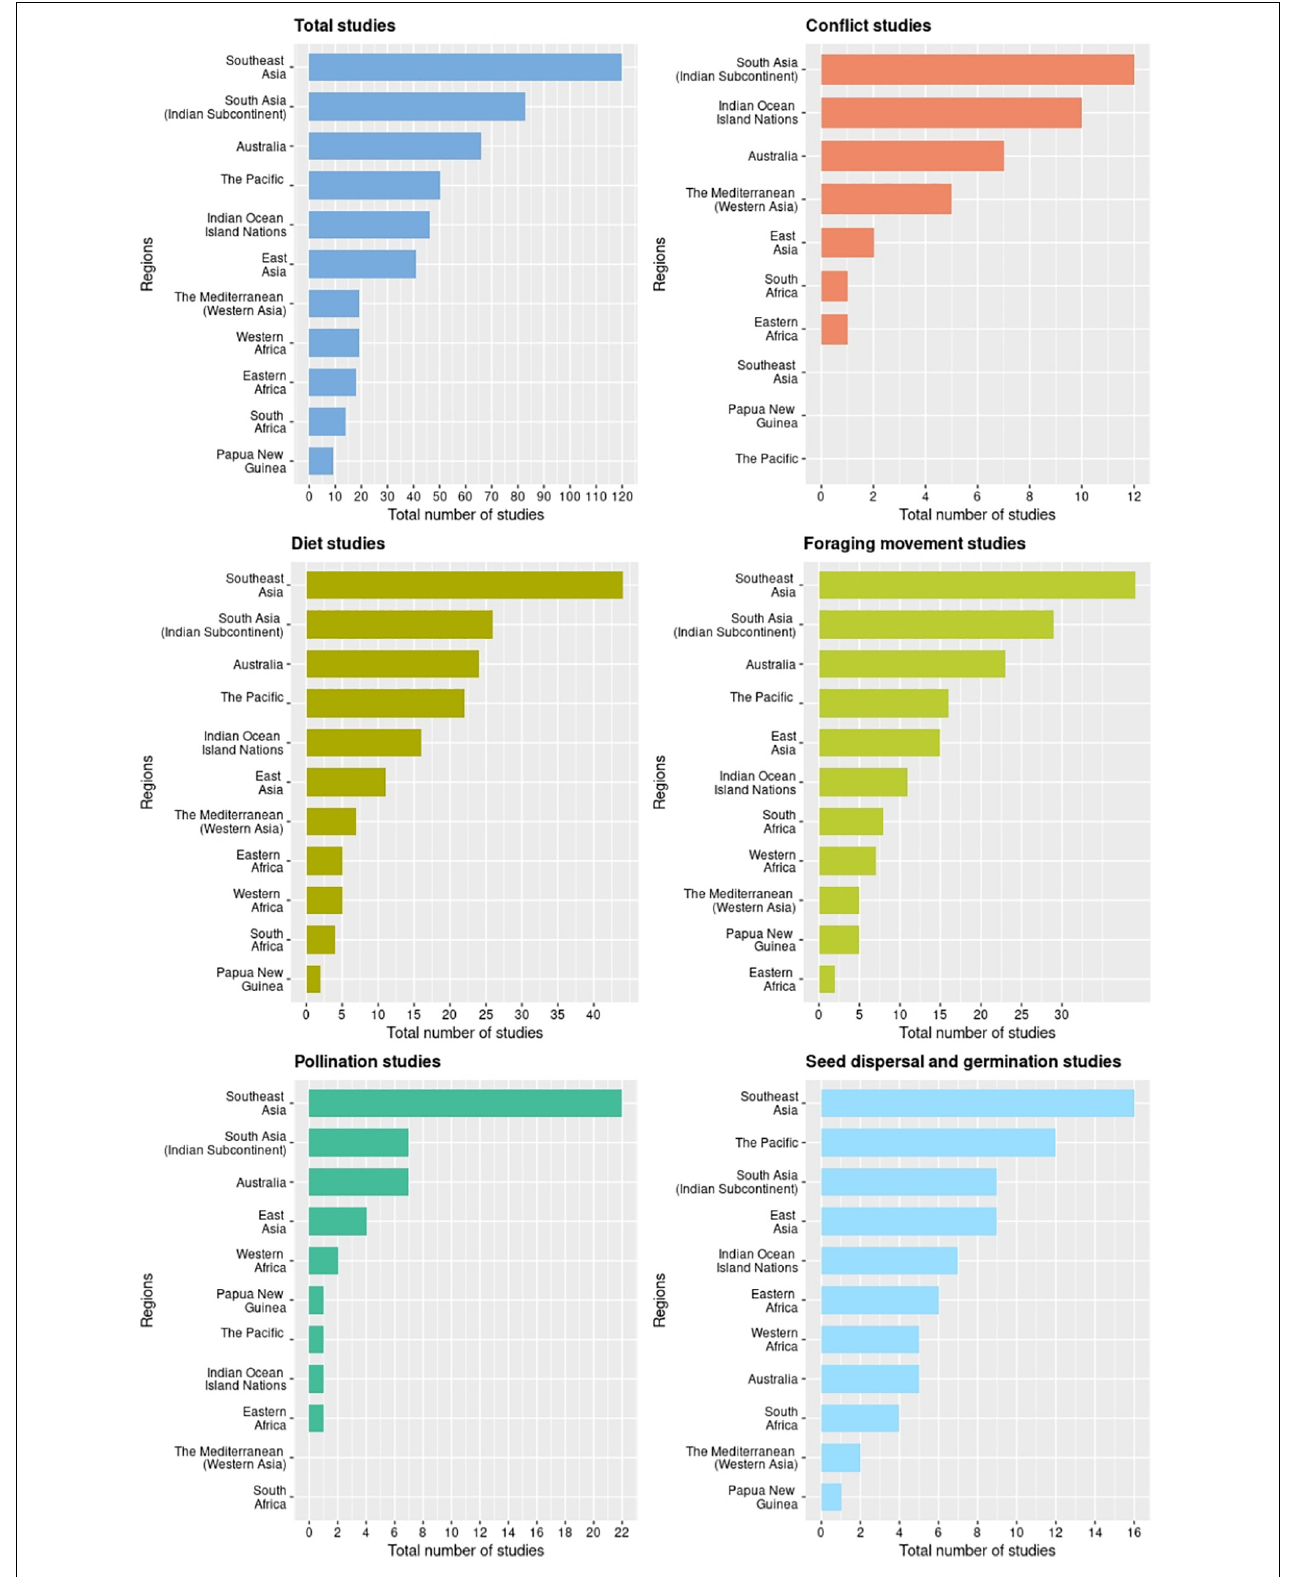
FIGURE 1 | Geographical distribution of research on Old World bat-plant interactions across five major themes during 1985-2020.